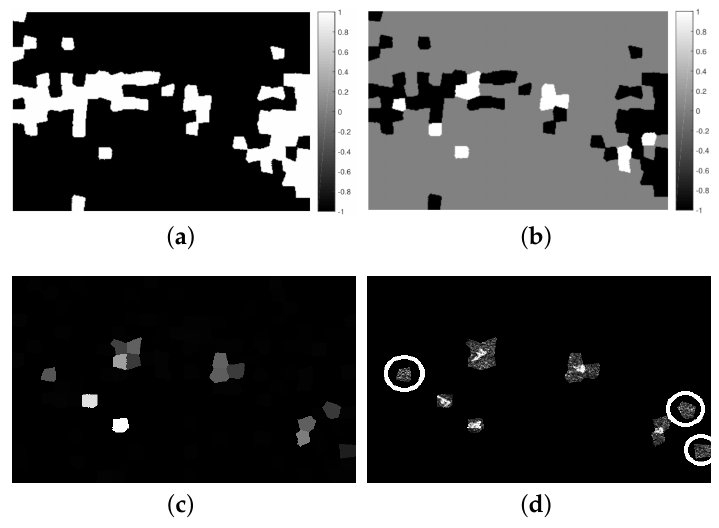
Figure 6. The correction amount and recursive result of simulated SAR image. ( a ) Correction amount of background 1; ( b ) Correction amount of background 2; ( c ) Saliency recursive results; ( d ) Global detection results.